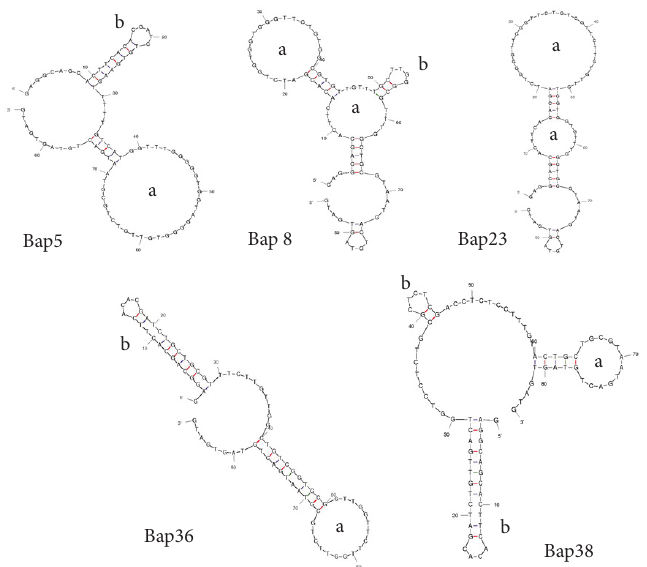
Figure 3: Secondary structures of the candidate aptamers predicted by Mfold.